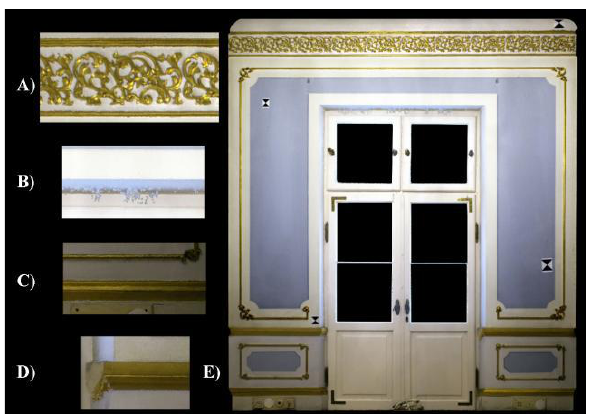
Figure 7. E) An orthoimage generated from integration of point clouds from TLS and image matching. (A-D) Zooms show selected elements of the processed